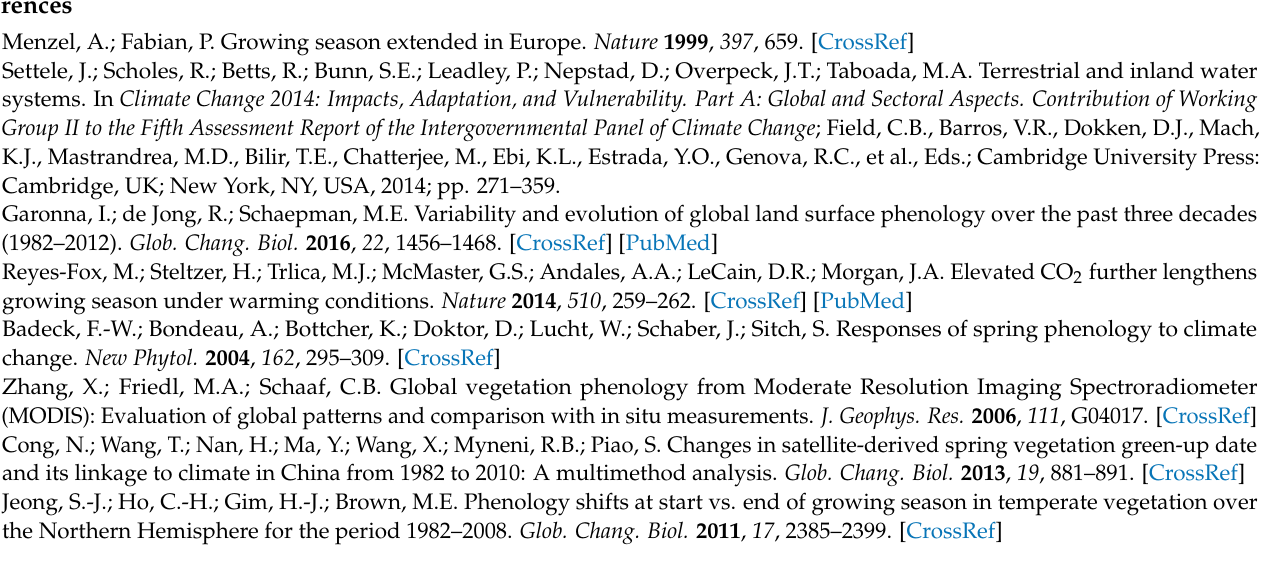
Table S2: Annual onsets of the start, end, and length of the MODIS-derived cropland growing season in Northeast China from 2001 to 2010. LCL and UCL are the lower and upper limits of the 90% confidence